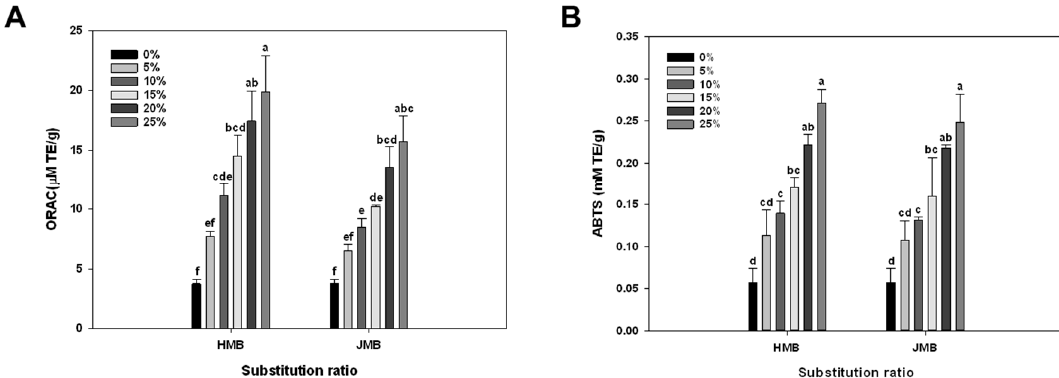
Figure 3. Effects of various substitution ratios of HMB or JMB on antioxidant activity of breads by ( A ) oxygen radical absorbance capacity (ORAC) and ( B ) 2, 2 ′ -Azino-bis (3-ethylbenz-thiazoline-6-sulfonic acid (ABTS) assay. HMB: bran pulverized by hammer mill, JMB: bran pulverized by jet mill. Bars with different characters indicate a significant difference at p ≤ 0.05.